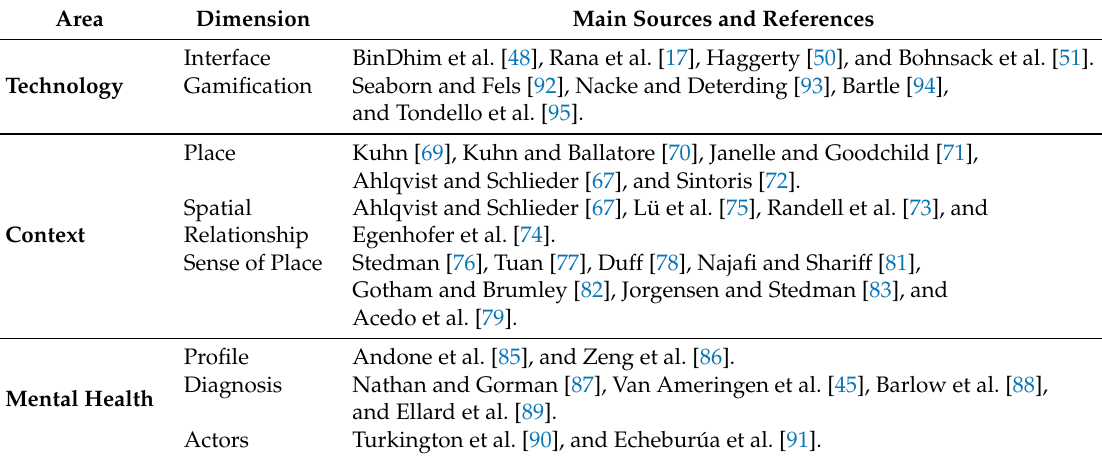
Table 3. Summary of selected dimensions grouped by area of knowledge, together with the main sources and references analyzed to reinterpret each